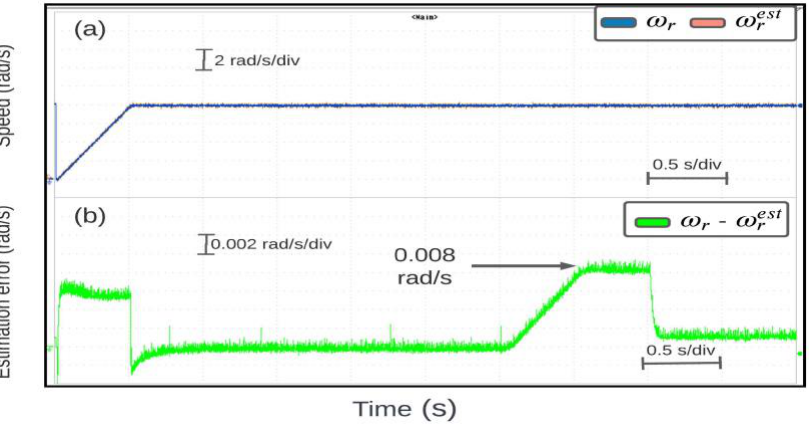
Figure 18. OeW-5PIM performance under stator parameter changes ( a ) speeds responses; ( b ) estimation error.